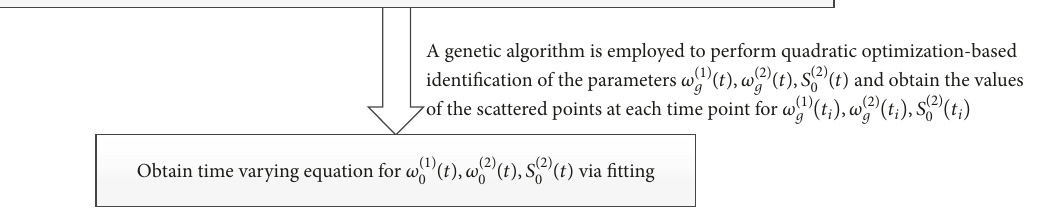
Figure 1: Process of determining the values of the parameters in the bimodal time-varying Kanai-Tajimi model.